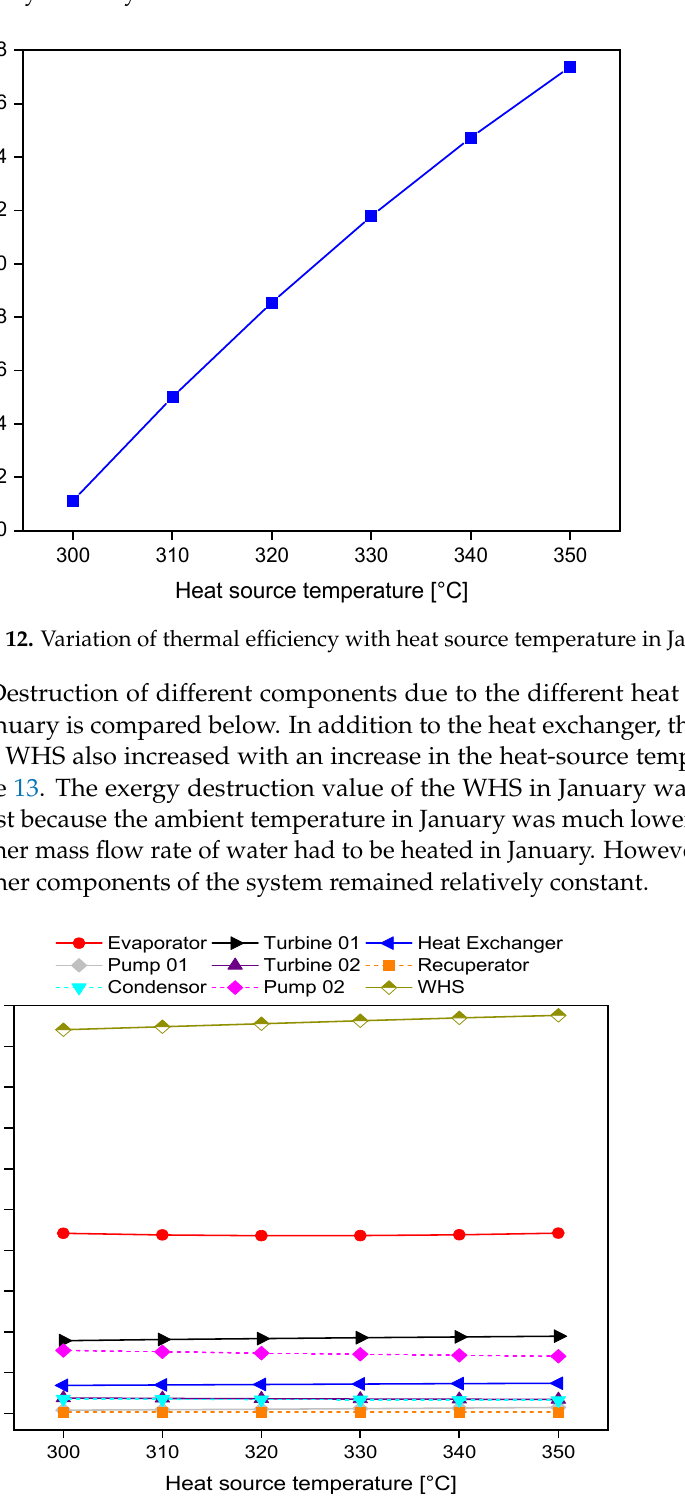
Figure 13. Variation of individual components exergy destruction with heat source temperature in January.